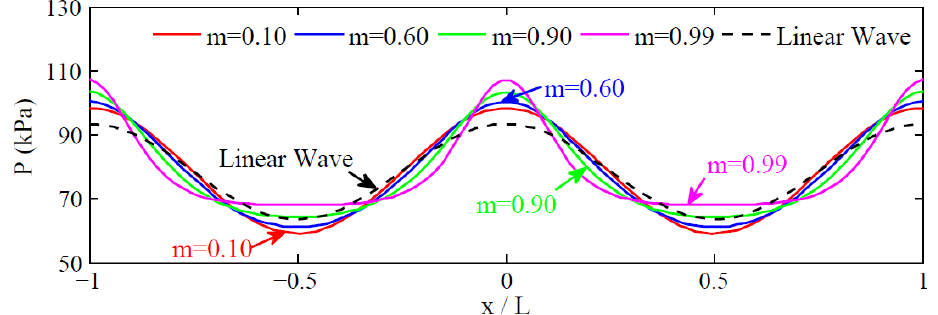
Figure 2. Waveforms of the cnoidal wave-induced hydrodynamic loading on the surface of a seabed floor with different values of m (note: hydrostatic pressure is included, and L is the wavelength).